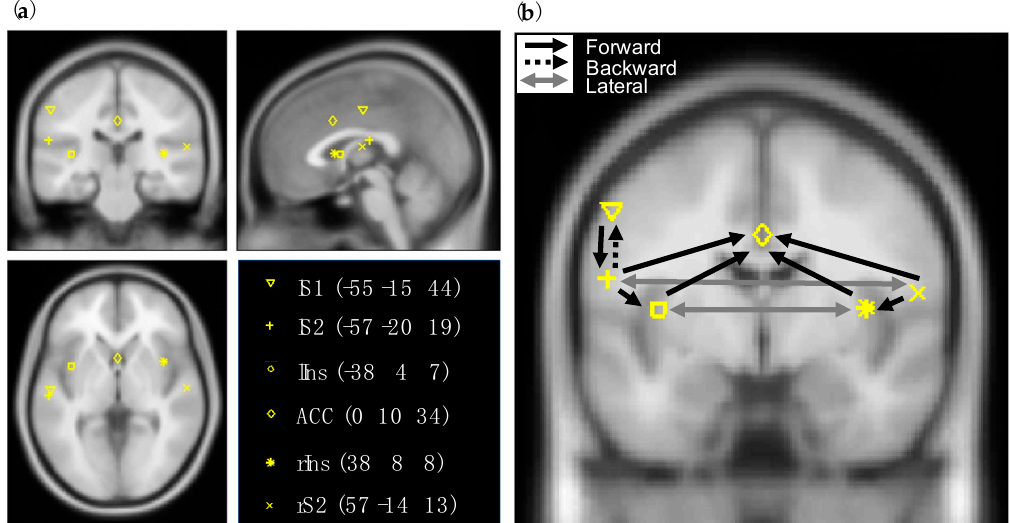
Figure 1. The regions and connectivity pattern between them as specified in the dynamic causal modelling (DCM) analysis. ( a ) Prior MNI coordinates of the laser-evoked potentials (LEPs) sources. ( b ) Forward, backward and lateral connections that were estimated with DCM. Note that for visibility reasons the forward connections from the hidden source (thalamus) to all the regions and backward connections from those regions to the hidden source are not displayed in the figure but were estimated. For the spatial forward model, the equivalent current dipole method was used (‘ECD’ option in SPM12). Canonical T1 images and the boundary element method (BEM) were used to obtain leadfield